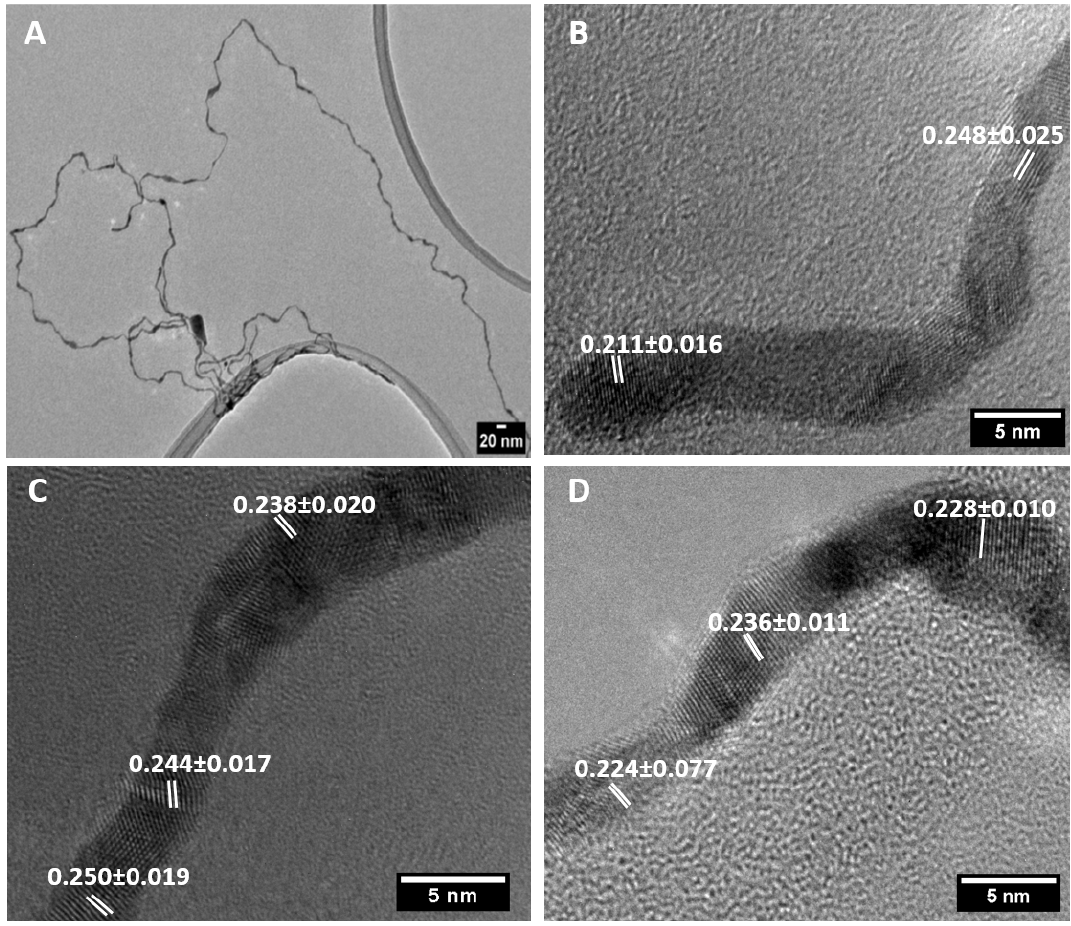
Figure 3. TEM image ( A ) and HRTEM images ( B – D ) of ultrathin AuAg nanowires (NWs) produced following dilution after aging at 25 °C for 18 h. All d-spacing values are expressed in nanometres.